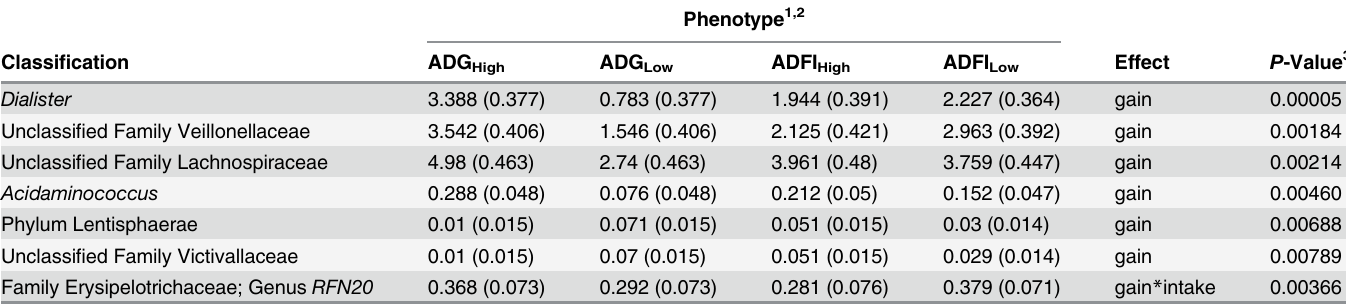
Table 4. Relative abundance of taxa within ADG and